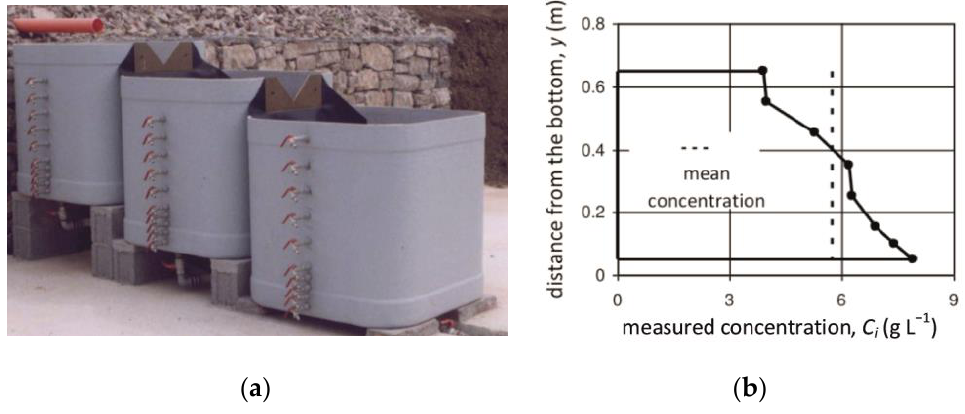
Figure 2. View of the ( a ) storage tanks and ( b ) concentration profile (modified from